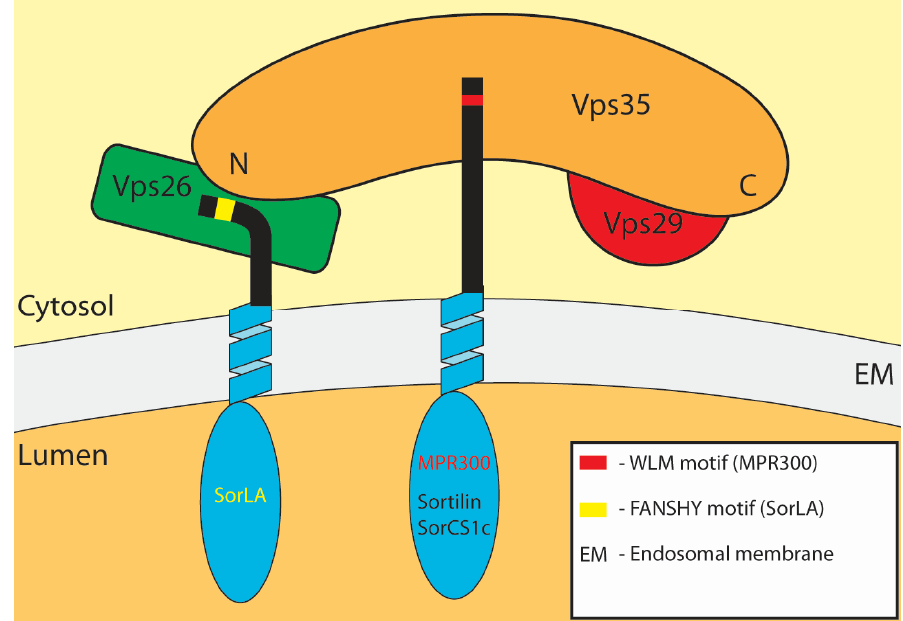
Figure 2. Retromer interactions with type-1 receptors. The retromer core complex consists of Vps35, Vps26 and Vps29. The banana-shaped Vps35 interacts with Vps26 through its N-terminal and Vps29 through the C-terminal. Located at endosomes, type-1 receptors have been reported to bind to Vps35 as well as Vps26. MPR300, sortilin and SorCS-1C bind Vps35; MPR300 via a WLM motif while the binding motifs in sortilin and SorCS-1C are unknown. Sortilin may also interact with Vps26, whereas SorLA has only been reported to bind Vps26 through a FANSHY